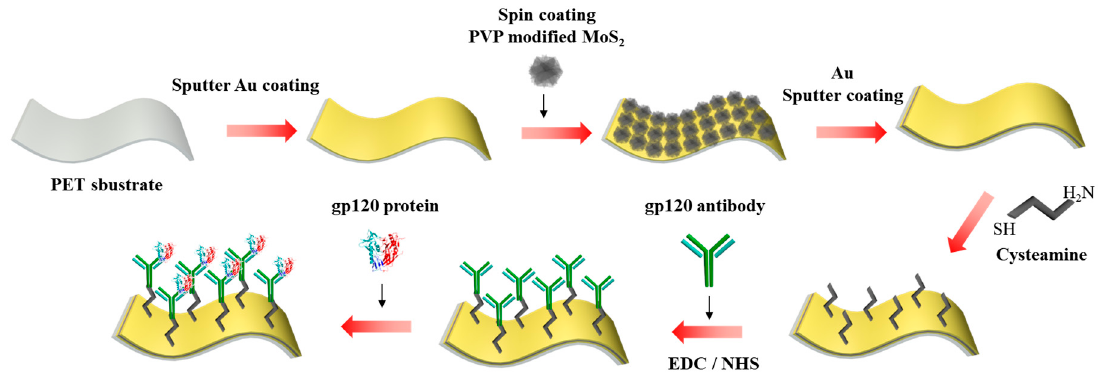
Figure 1. Schematic image of the fabrication of the flexible biosensor composed of gp120 antibody (Ab) / cysteamine (Cys) / Au / MoS 2 / Au nanolayer on the polyethylene terephthalate (PET) substrate for the detection of